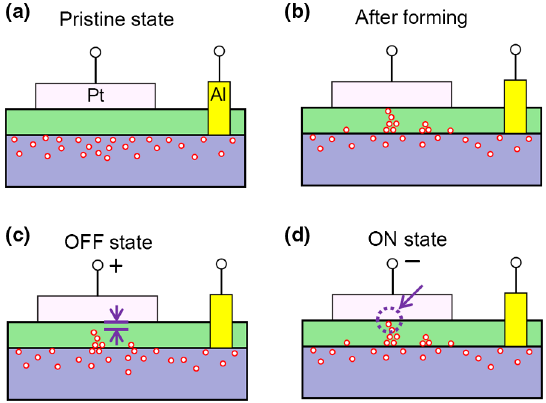
FIG. 8. Schematic illustration of the RS mechanism in Pt/ LAO/STO devices. (a) In the pristine state, the as-grown LAO layer is insulating, and the CPP transport is of the tunneling type. However, (b) after the forming process, conducting filaments of oxygen vacancies form across the LAO layer, giving rise to the Ohmic transport. As shown in (c) and (d), the close and open actions of the ‘‘electric faucet’’ near the filament or electrode interface are responsible for the HRS and LRS. In (c), the arrows mark the effective thickness of the LAO layer that remains as an insulating barrier. The region of the electric faucet is highlighted in